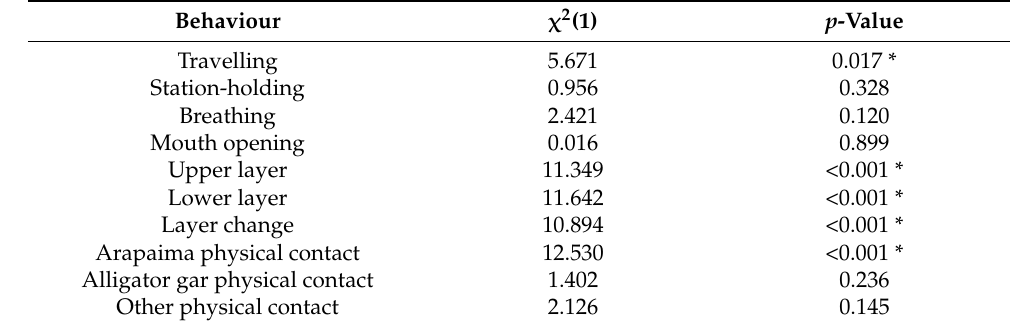
Table 5. Results of observed frequency likelihood ratio test comparing the two linear mixed models, one with and the other without the fixed effect (effect of the use of the green laser pointer).